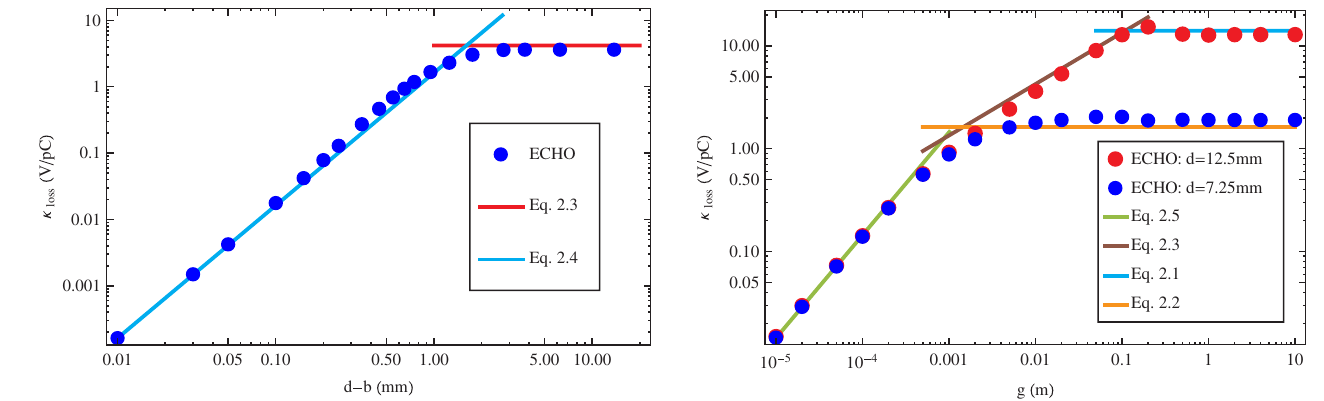
FIG. 6. (Color) For a Gaussian bunch of rms length (cid:1) ¼ 0 : 5 mm , we show the results of ECHO calculations of the loss factor as a function of gap g for a pillbox cavity with parameters d ¼ 12 : 5 mm , b ¼ 6 : 25 mm (red dots) and d ¼ 7 : 25 mm , b ¼ 6 : 25 mm (blue dots). The green line represents Eq. (2.5) in the slot regime; the brown line represents Eq. (2.3) in the cavity regime; the aqua line represents Eq. (2.1) in the step regime ( d (cid:2) b (cid:4) (cid:1) ); and the orange line represents Eq. (2.2) in the step regime ( d (cid:2) b < (cid:1)